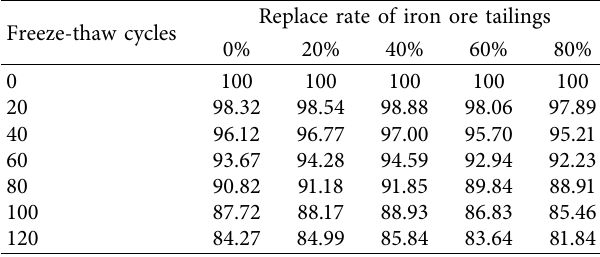
Table 7: Relative dynamic elastic modulus ( P tailings concrete after freeze-thaw (%).